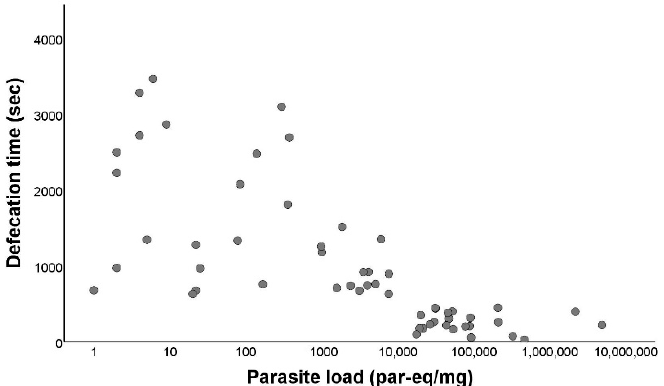
Figure 5. Defecation activity of Triatoma infestans according to Trypanosoma cruzi parasite load. Par- asite load (LOG 10 ) in relation to defecation time, in seconds. Defecation time is defined as the time elapsed between the end of the blood intake and the start of the dejection release.